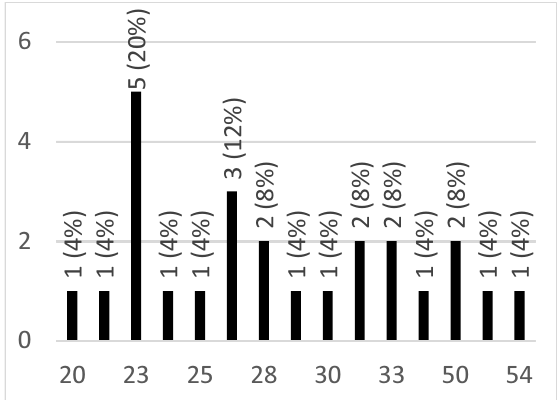
Figure 9. Age distribution of